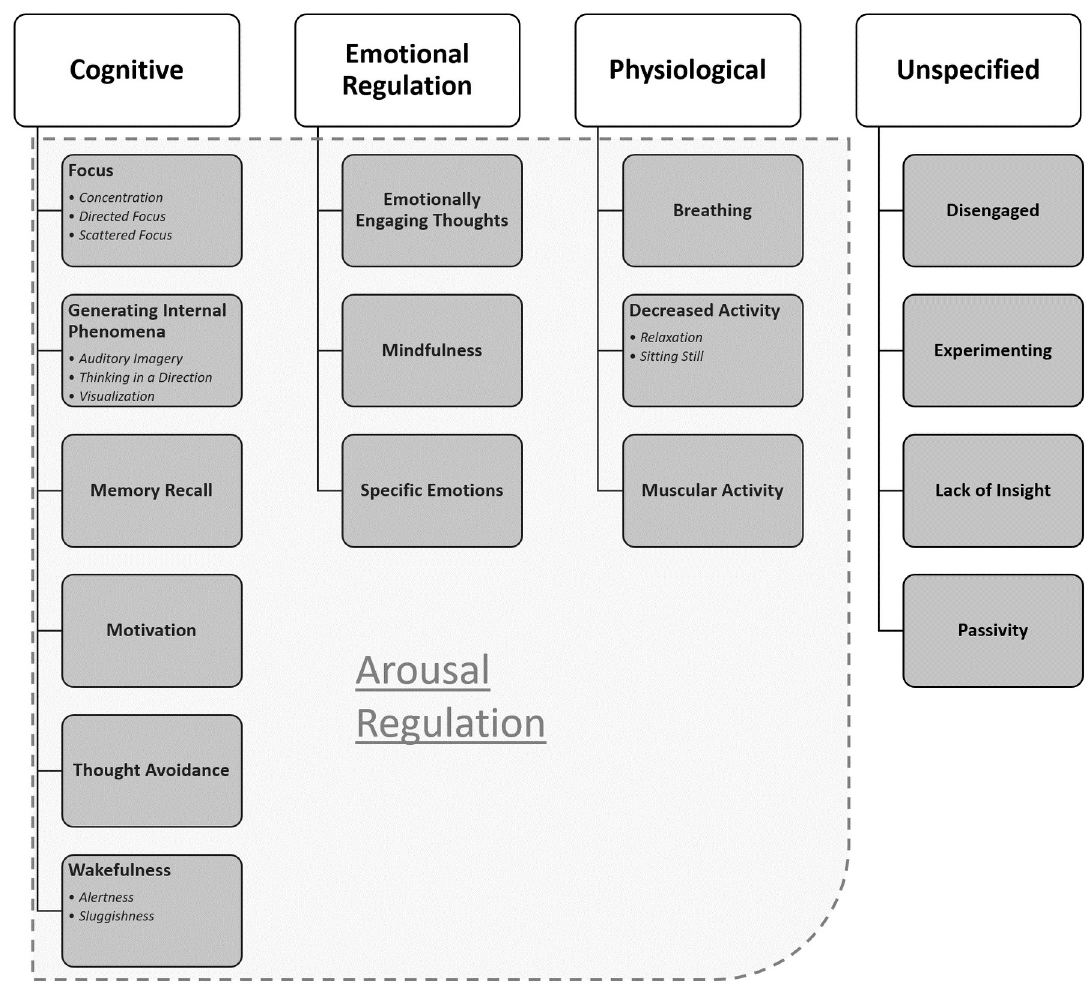
Fig 2. Hierarchical overview of themes and sub-themes. The above figure shows the four identified domains: Cognitive, Emotional Regulation, Physiological & Unspecified . Below each domain themes are illustrated as boxes, with sub-themes inside the box. The dotted line illustrates the latent themes (Arousal Regulation) and where it overlaps with the other